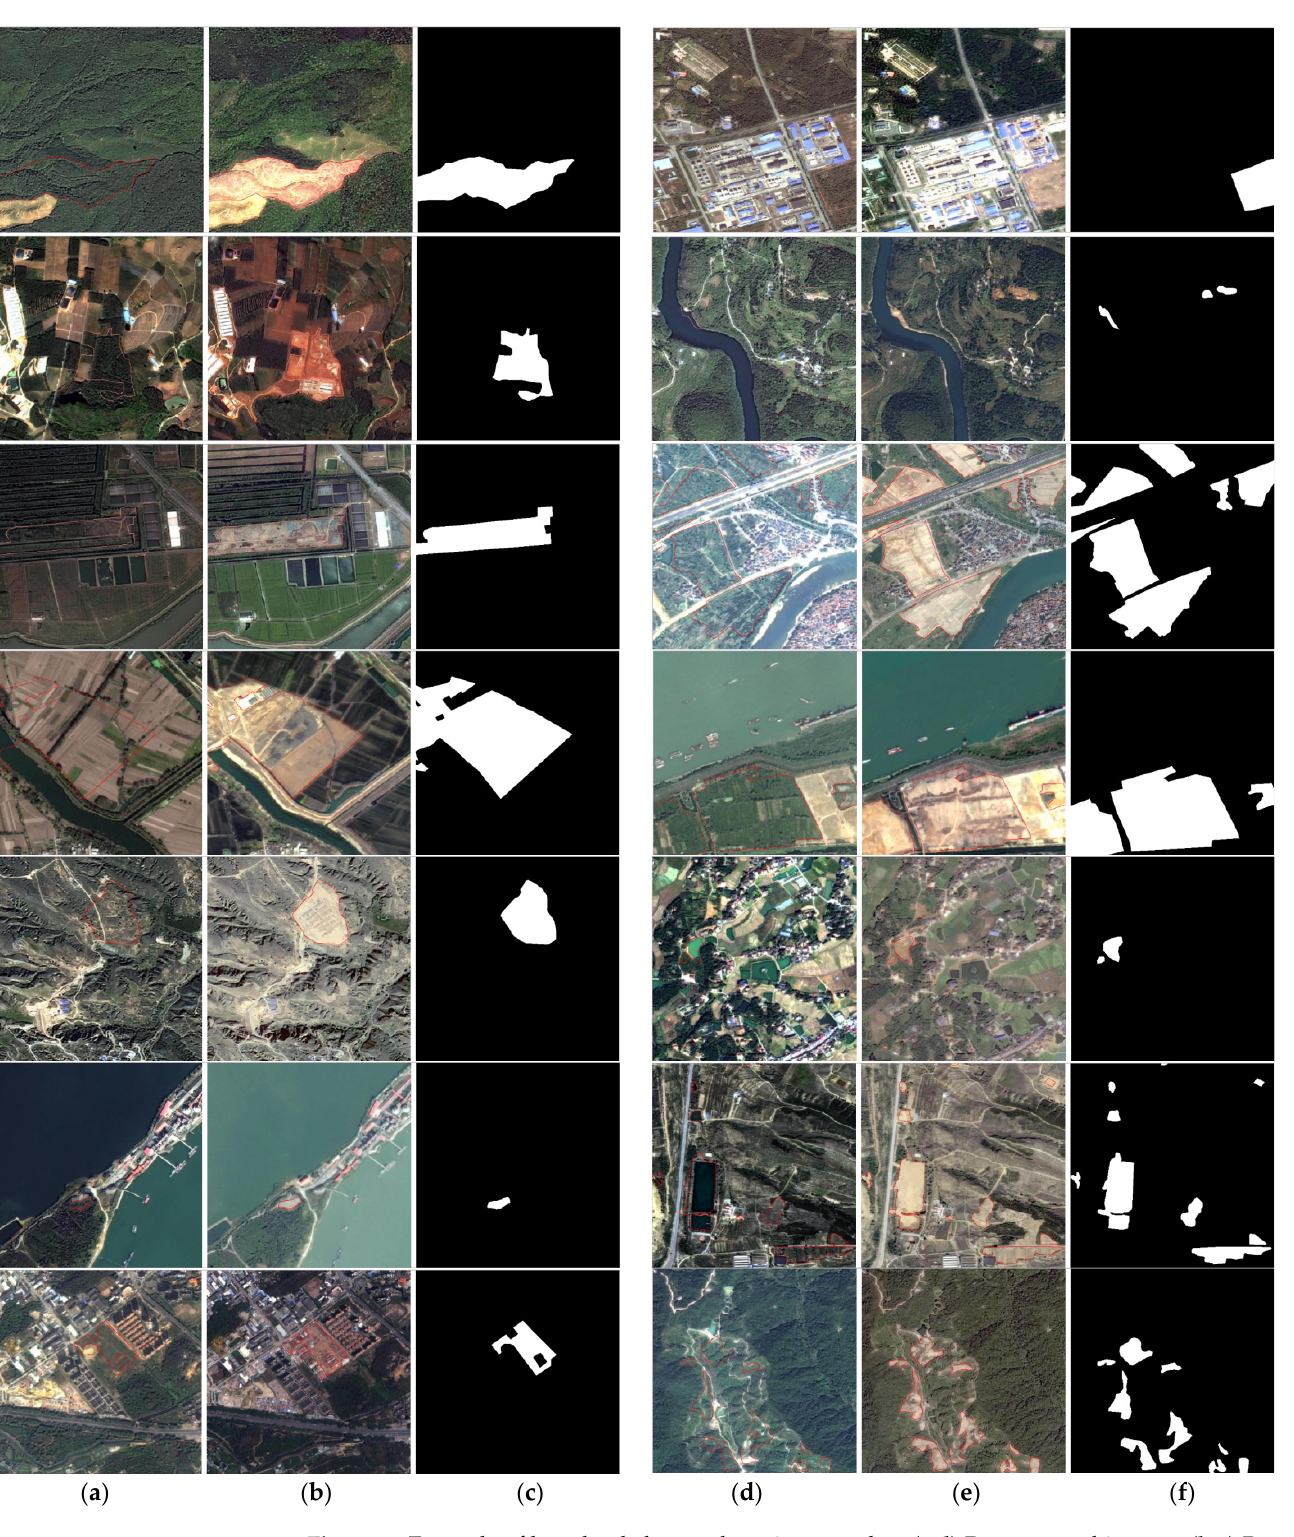
Figure 8. Example of bare land change detection samples. ( a , d ) Pre-temporal images; ( b , e ) Post- temporal image; ( c , f ) labels. temporal image; ( c , f )